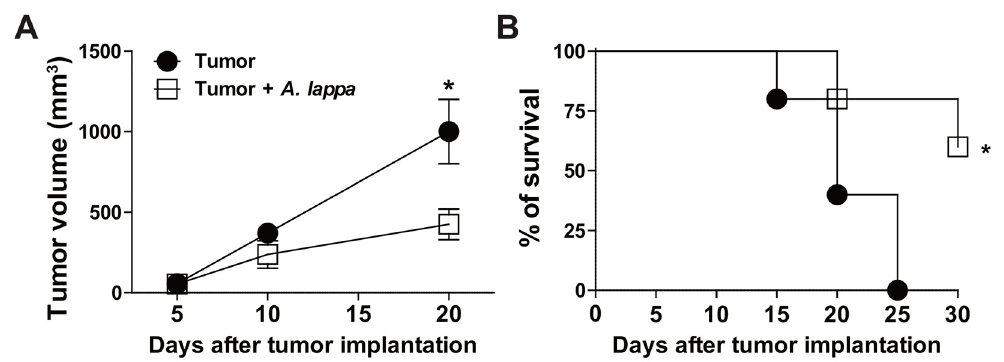
Figure 4. A. lappa extract reduces tumor growth and rescues animal mortality. ( A ) For assessment of tumor size and ( B ) mice survival, B16F10 melanoma cells were implanted and the animals received Alhe (50 mg / kg / 300 µ L) or PBS (300 µ L) every 5 days for 30 days. ( A ) Tumors were measured with a Vernier caliper, and tumor volume was calculated with the equation—tumor length × height × width / 2. ( B ) Animal survival was monitored for 30 days. The experiment was conducted twice using five mice per group (n = 5). Data denote mean ± SEM. * Tumor versus tumor + A. lappa . Di ff erences were considered significant with p < 0.05, according to ANOVA with Tukey’s post-test (tumor growth) or the log-rank test (mice